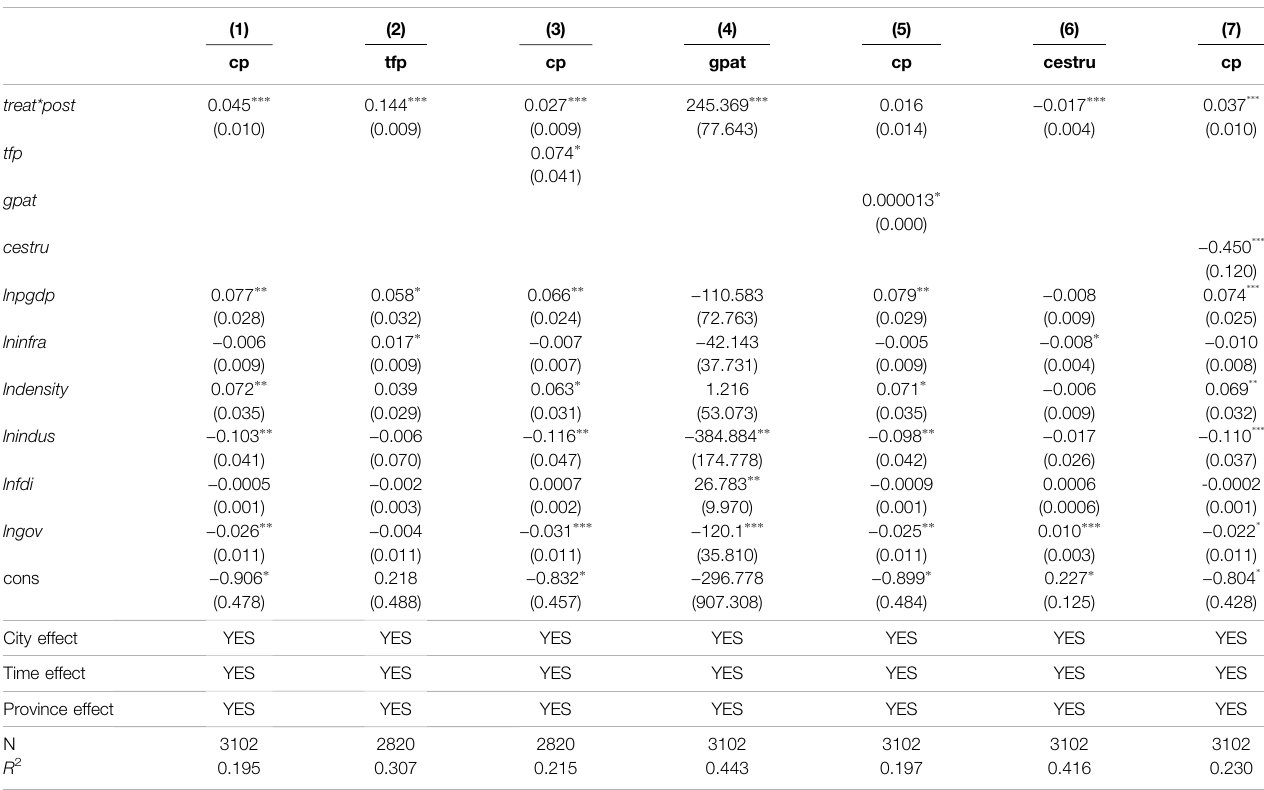
TABLE 5 | The results of the mediating